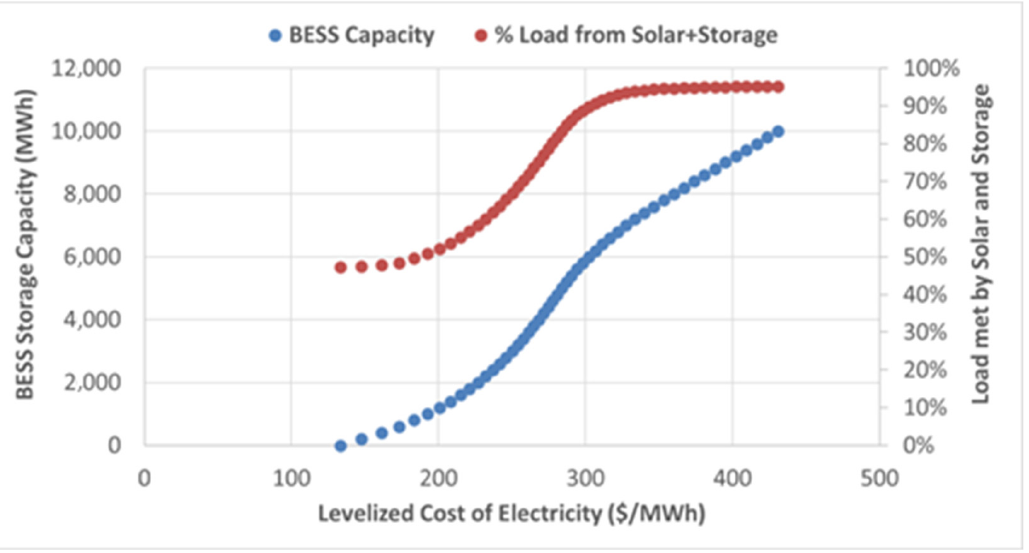
Figure 5. Effects on levelized cost of electricity and percentage of load met by increasing battery energy storage capacity in the 100-mile 230 kV scenario.